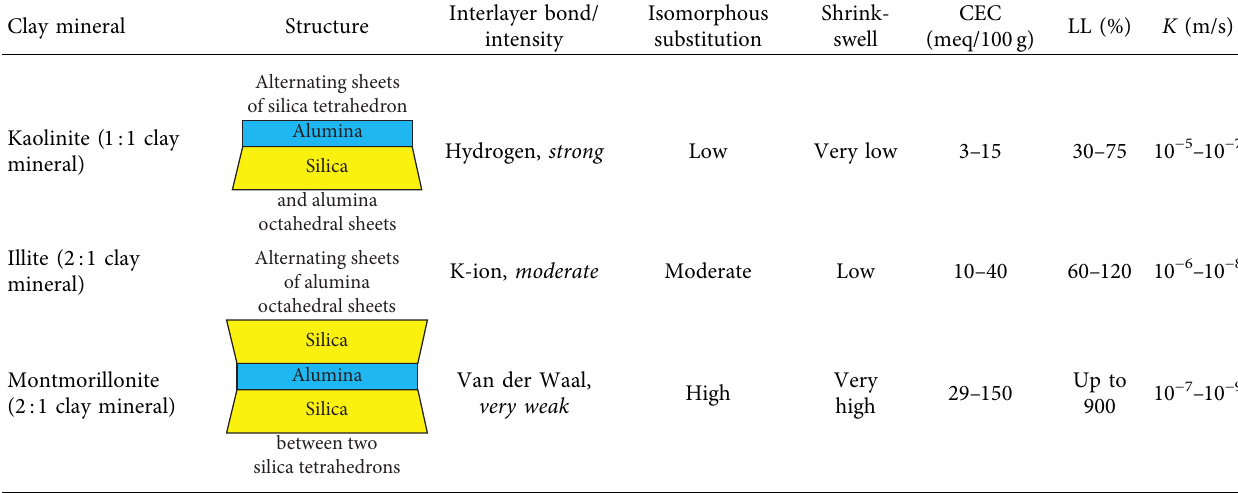
Table 2: Mineralogical properties of basic clay minerals (kaolinite, illite, and